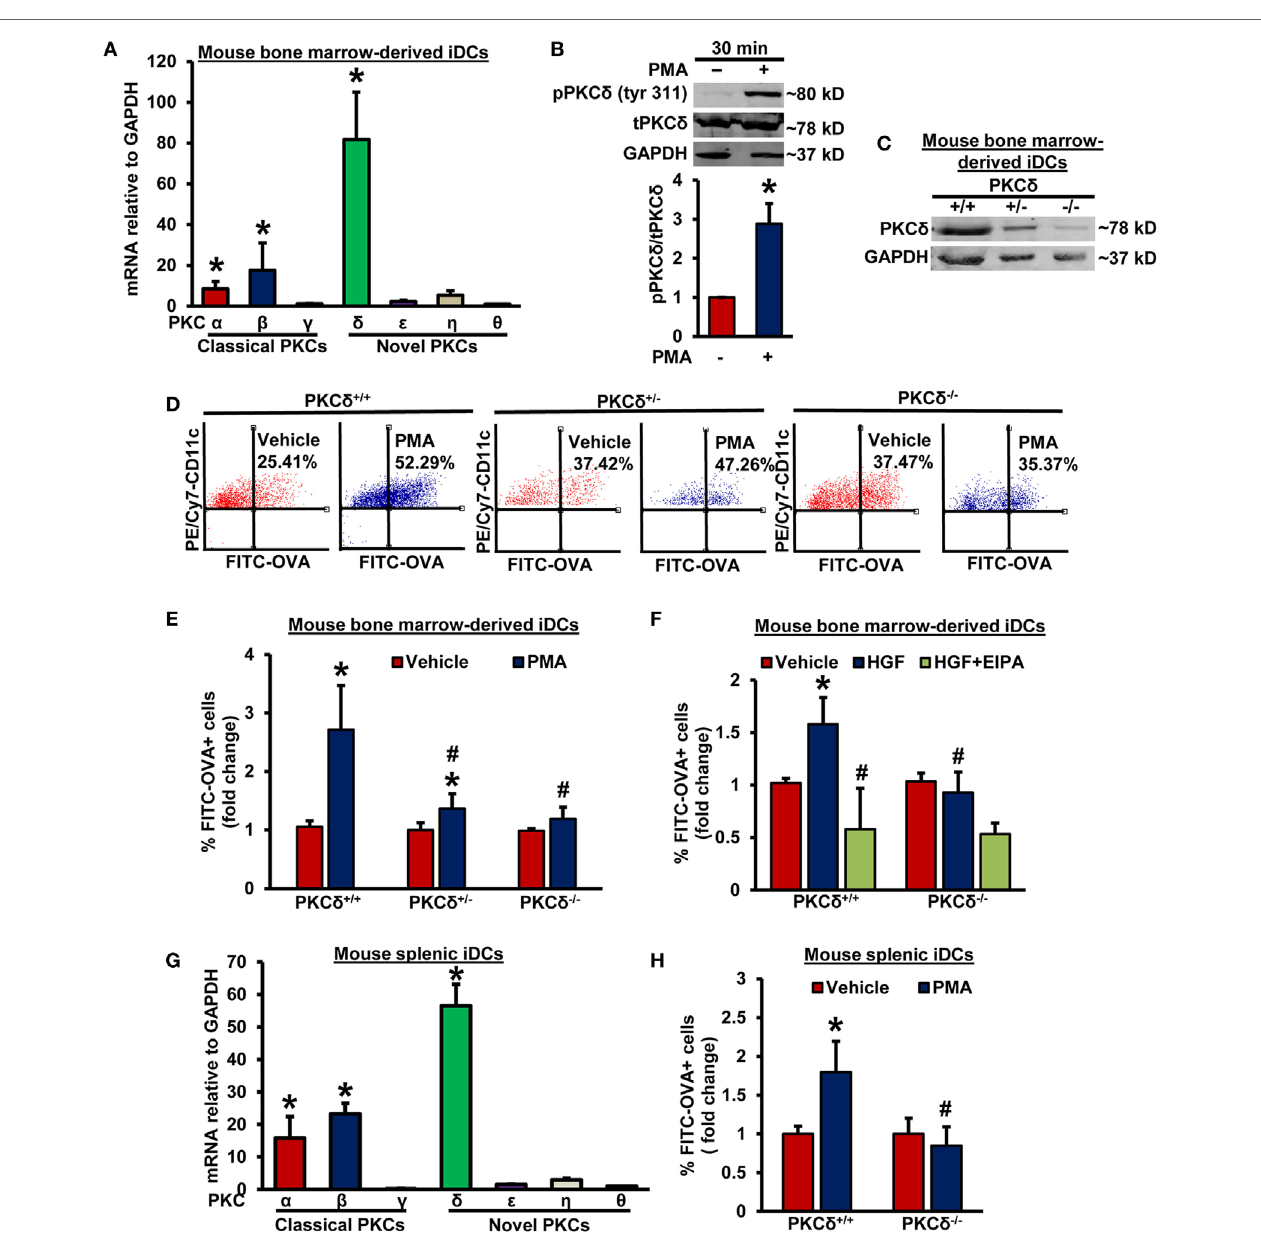
FigUre 2 | PKC δ activation mediates macropinocytosis of antigens by iDCs. (a) WT CD11c + BMiDCs were subjected to qRT-PCR to determine mRNA expression of classical and novel protein kinase C (PKC) isoforms. GAPDH was used as an internal control. The transcript levels were calculated using delta–delta-CT method. Bar graph represents mRNA levels of classical and novel PKC isoforms in comparison to PKC θ (gene with lowest expression). Data represent the mean ± SEM. * p < 0.05 vs. PKC θ . (B) WT BMiDCs were treated with vehicle or PMA (1 µM) for 30 min. Cell lysates were used for Western blot analysis of phospho- PKC δ (tyr311), total PKC δ , and GAPDH protein expression. Representative Western blot images are shown. Bar graph represents averaged protein levels determined using densitometric analysis and expressed as a ratio of phospho- to total PKC δ ( n = 6). (c) CD11c + BMiDCs from three PKC δ + / + , PKC δ + / − , and PKC δ − / − mice were pooled and Western blot was performed with cell lysates to validate deletion of PKC δ in DCs. (D) PKC δ + / + , PKC δ + / − , and PKC δ − / − BMiDC were incubated with FITC-OVA (50 µg/mL) with or without PMA (1 µM) for 5 h. FITC fluorescence was analyzed using a Becton Dickinson FACSCalibur flow cytometer. (e) Bar diagram shows the fold change in mean FITC fluorescence + cells among CD11c + PKC δ + / + , PKC δ + / − , and PKC δ − / − DCs ( n = 6). (F) PKC δ + / + and PKC δ − / − BMiDC were preincubated for 30 min with EIPA (25 µM), and treated with hepatocyte growth factor (HGF, 100 ng/mL) for 5 h in the presence of FITC-OVA. FITC-OVA internalization was analyzed by fluorescence-activated cell sorting (FACS) ( n = 4). (g) WT CD11c + splenic iDCs were subjected to qRT-PCR for determination of various PKC isoforms. GAPDH was used as an internal control. Bar graph represents mRNA levels of PKC isoforms in comparison to PKC θ (gene with lowest expression). Data represent the mean ± SEM. * p < 0.05 vs. PKC θ . (h) Splenic iDCs from PKC δ + / + and PKC δ − / − mice were treated as described in Figure 2D for 1 h, and FITC fluorescence analyzed using FACS ( n = 3). Data represent the mean ± SD. * p < 0.05 vs. vehicle, and # p < 0.05 vs. PKC δ + / +